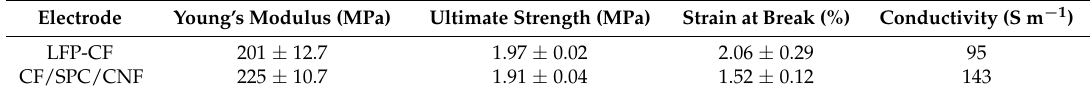
Table 2. Mechanical properties and conductivity of flexible